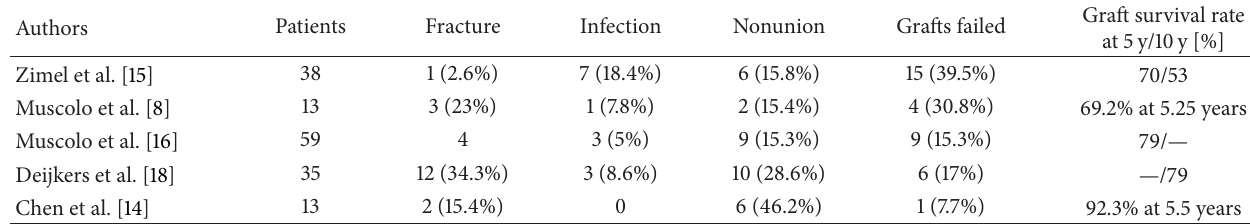
Table 1: Comparison of intercalary allograft reconstructions in the lower limb.